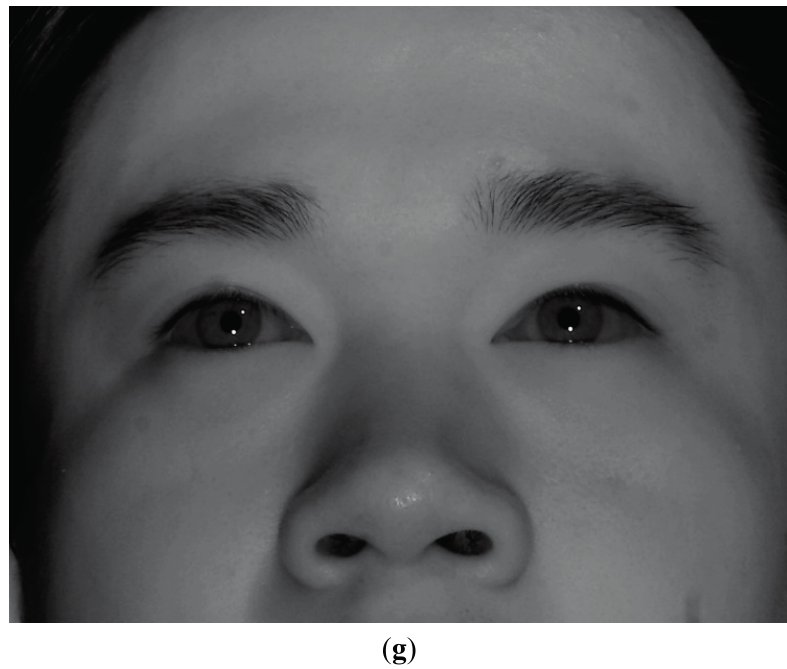
Figure 33. The examples of relationships among GPMA, IPMA, correct SR, and imposter SR in case of head rotations and translations while gazing at same position. The directions of rotations and translations are shown in Figure 31. In each eye image of Figure of ( a )~( g ), upper and lower SRs are imposter and correct SRs, respectively. ( a ) before head movement; ( b ) head rotation in X axis; ( c ) head rotation in Y axis; ( d ) head rotation in Z axis; ( e ) head translation in X axis; ( f ) head translation in Y axis; ( g ) head translation in Z axis.